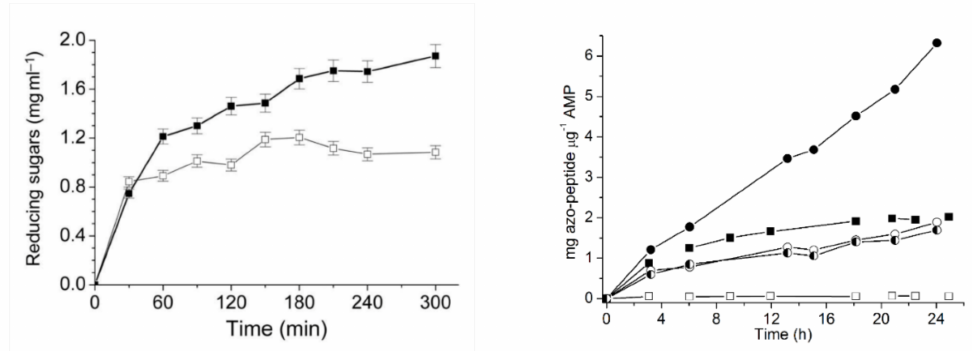
Figure 2. Productivity curves for alkaline metalloprotease, α -amylase ( left ), and AMP ( right ). Starch hydrolysis by α -amylase at 60 ◦ C as determined by the formation of reducing sugars. Sodium acetate/acetic acid buffer (50 mM, pH 5) and enzyme (0.32 µ g mL − 1 ) were added to the starch solution (6% w/v ), to initiate the reaction. Open symbols: Unmodified α -amylase; filled symbols: Modified α -amylase (reproduced from [16] with permission from Oxford University Press). Protein hydrolysis by native, EDTA-treated, and Ca 2+ -treated alkaline metalloproteases (AMP) at different temperatures. Formed azo-peptide (mg µ g − 1 AMP) was measured using azocasein as substrate (1% w/v ) in 0.1 M MES-NaOH buffer, pH 6.5 over a period of 24 h. Circles: Reaction performed at 40 ◦ C; squares: Reaction performed at 48 ◦ C. Open symbols: EDTA-treated AMP; half-filled symbols: Native enzyme; filled symbols: +5 mM Ca 2+ (reproduced from [17] with permission from